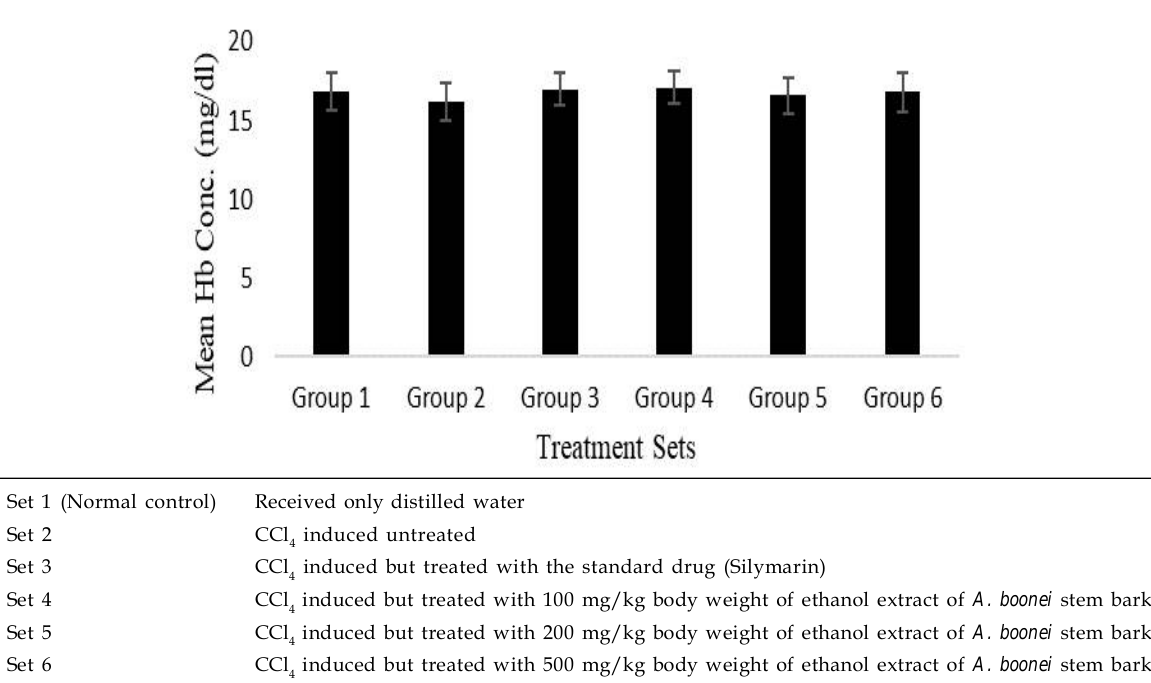
Figure 6: Hb concentration of male Wistar albino rats administered with A. boonei stem bark extract